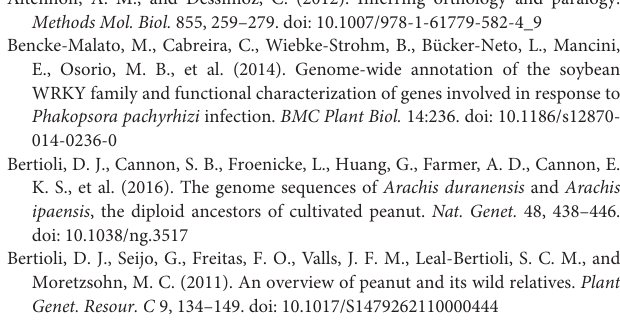
Figure S2 | Phylogenetic tree of AtWRKY and AiWRKY domains. The phylogenetic tree was constructed using MEGA 6.0 by the Neighbor-Joining (NJ) method with 1000 bootstrap replicates. Figure S3 | Phylogenetic tree of AdWRKY and AiWRKY proteins. The phylogenetic tree was constructed using MEGA 6.0 by the Neighbor-Joining (NJ) method with 1000 bootstrap replicates. Figure S4 | Phylogenetic tree of AdWRKY and GmWRKY proteins. The phylogenetic tree was constructed using MEGA 6.0 by the Neighbor-Joining (NJ) method with 1000 bootstrap replicates. Figure S5 | Phylogenetic tree of AiWRKY and GmWRKY proteins. The phylogenetic tree was constructed using MEGA 6.0 by the Neighbor-Joining (NJ) method with 1000 bootstrap replicates.